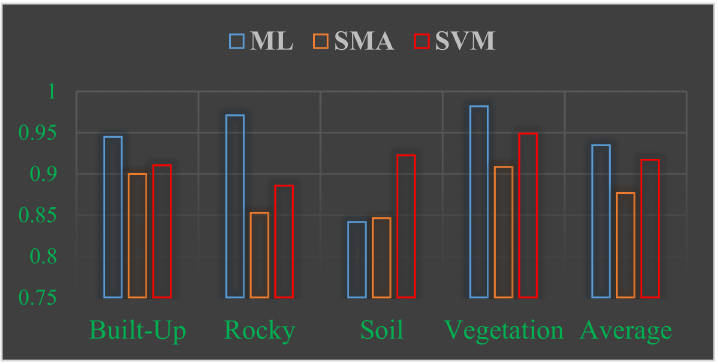
Figure 9. Producer’s accuracy of prediction